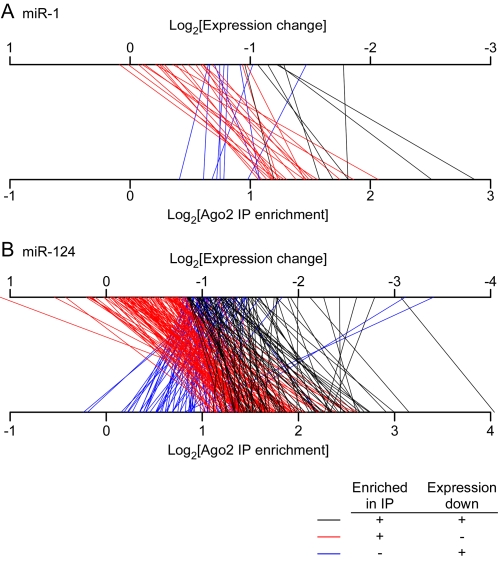
Relationship between overrepresentation in Ago2 IP and changes in mRNA levels due to miR-1 and miR-124.(A) Lines connect the log2 of the average Ago2 IP enrichment value (bottom axis) to the log2 of the average mRNA expression change (top axis) for three groups of mRNAs from miR-1 experiments. This analysis contains only mRNAs with 7mer seed matches in their 3′-UTRs. Black lines correspond to mRNAs that were Ago2 IP targets (1% local FDR) and decreased significantly at the mRNA level (10% local FDR); seven mRNAs are in this group. Red lines correspond to mRNAs that were Ago2 IP targets but did not decrease significantly at the mRNA level; nevertheless, 20 of 22 mRNAs in this group are downregulated (log2 change<0) at the mRNA level (P<10−5, one-way binomial test). Blue lines correspond to mRNAs that decreased significantly at the mRNA level, but were not Ago2 IP targets; all 9 mRNAs in this group are overrepresented (log2 enrichment>0) in Ago2 IPs (P = 0.0006). (B) Same as in (A) except for mRNAs from miR-124 experiments. 82 mRNAs are in the black group. 109/121 mRNAs in the red group are downregulated at the mRNA level (P<10−15); and 63/65 mRNAs in the blue group are overrepresented in Ago2 IPs (P<10−15).